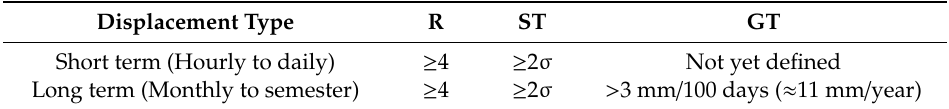
Figure 8. An example, using a simulated dataset, of daily solution for vertical displacement (Delta h). In the Day of Year 324, the displacement (green dot) is an insight into the statistical threshold ( ± 2 σ on the regression line) and below the geological threshold (GT). This means that normal conditions (green light–flag = 1). The days 316 and 317 have no measure because the ratio test was < 4. Table 3. The Ratio test (R) threshold, the statistical (ST), and the geological (GT) thresholds used for a Madonna del Sasso case study.